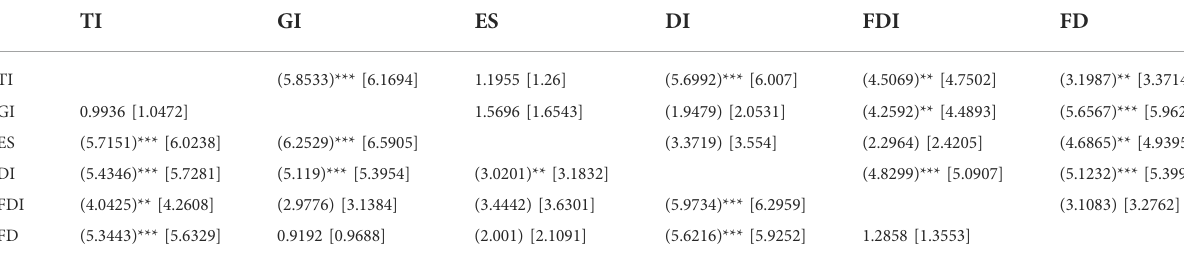
TABLE 9 Results of Dumitrescu and Hurlin ’ s (2012) panel causality test. TI GI